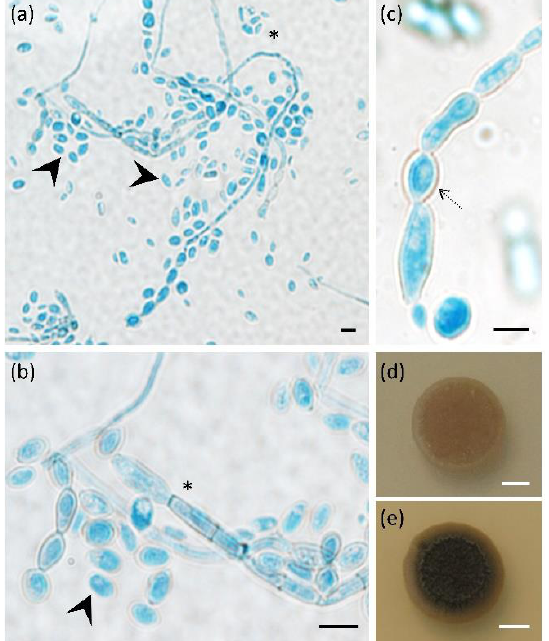
Figure 1. Morphological characteristics of Exophiala dermatitidis (EXF-10123). ( a ) Light microscope images (differential interference contrast, DIC) of Aniline Blue stained fungus grown on two different morphological media, ( a , b ) oatmeal agar (OA) and ( c ) malt extract agar (MEA); images show three different fungal growth forms, budding cells, (black arrow), pseudo-hyphae (black dotted arrow), and septate hyphae (asterisk). ( d , e ) E. dermatitidis is capable of growth at 37 °C. Culture on MEA plates incubated at ( d ) 25 °C and ( e ) 37 °C. Scale bar: 5 µm (black), 5 mm (white).